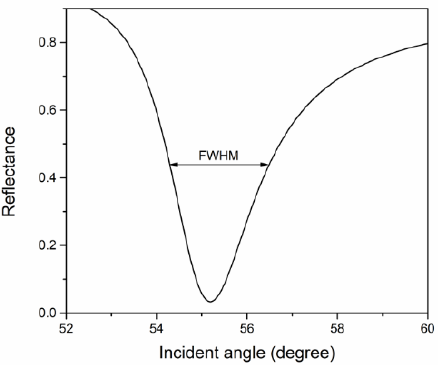
Figure 6. The full width half maximum (FWHM) of the SPR curve.